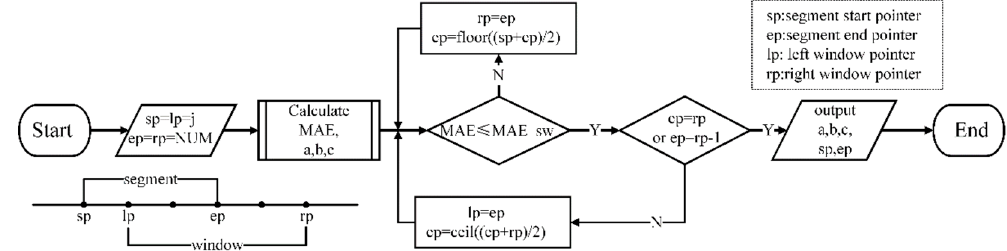
Figure 3. Calculation process of segment width maximization based on